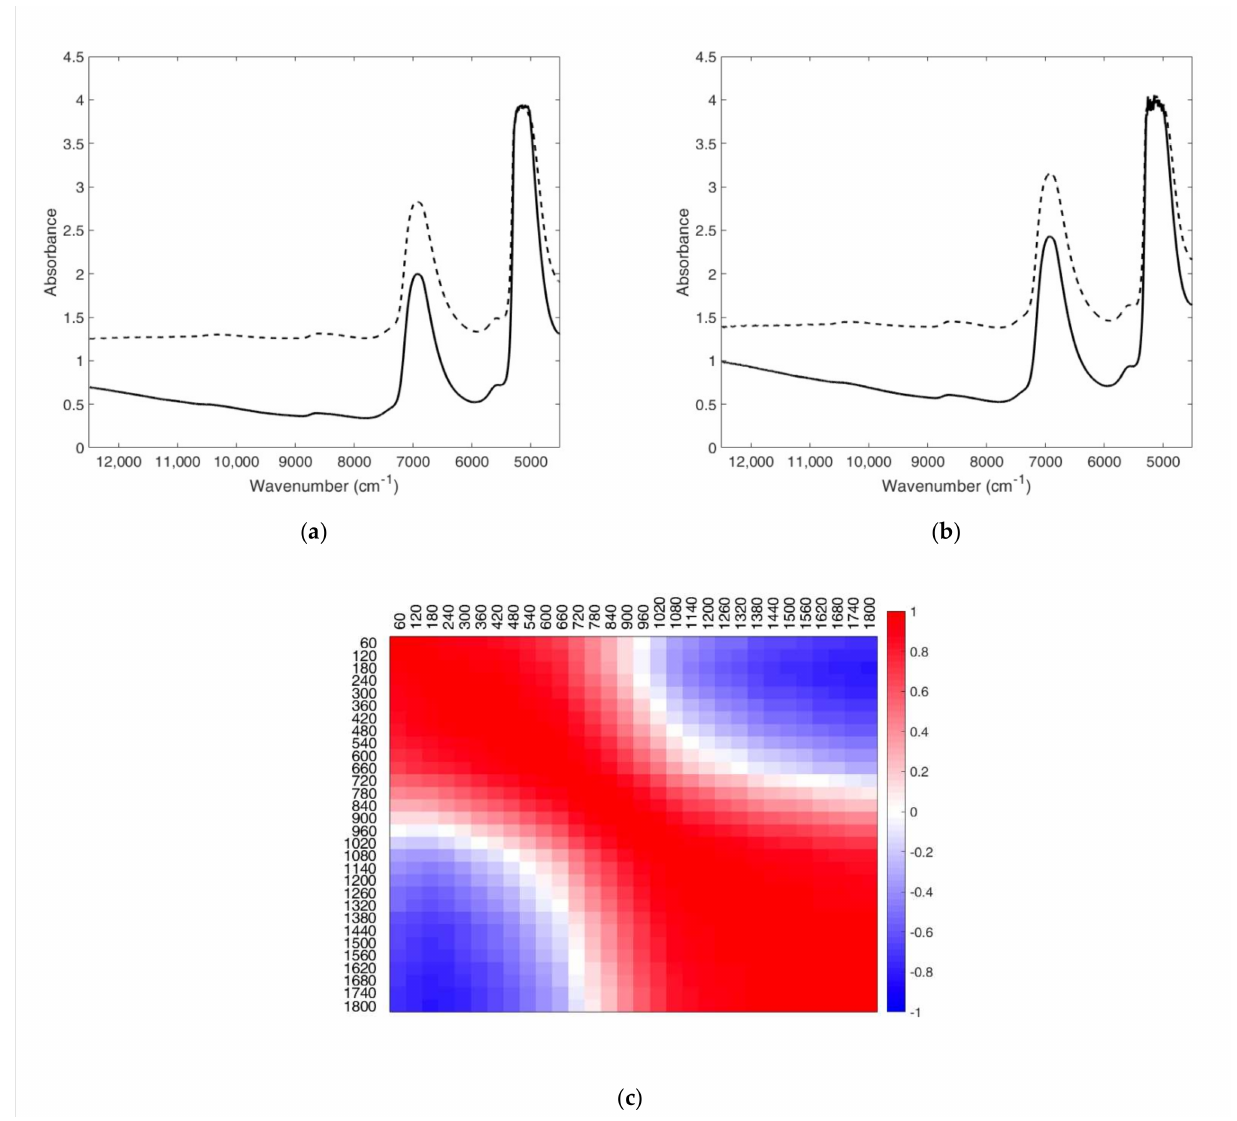
Figure 2. FT-NIR data for the trial EPI60-R1: ( a ) spectra collected at the beginning (bold line) and at the end of the coagulation (dashed line) by the 64-scan procedure; ( b ) spectra collected at the beginning (bold line) and at the end of the coagulation (dashed line) by the 9-scan procedure; ( c ) correlation coefficient map of the spectra collected from 60 to 1800 s of